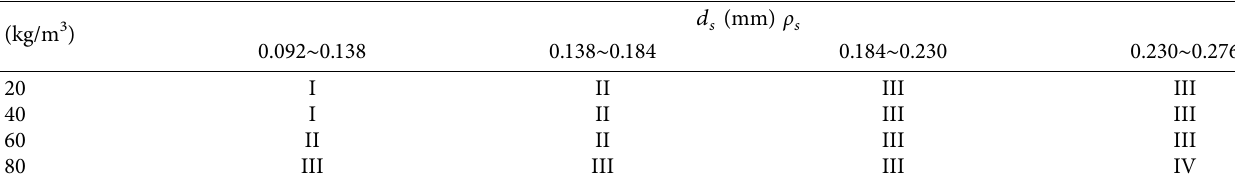
Figure 5: Four types of hysteresis curves. (a) I curve. (b) II curve. (c) III 1 curve. (d) III 2 curve. (e) IV curve. Table 2: Typical shapes and conditions of hysteresis curve at b �